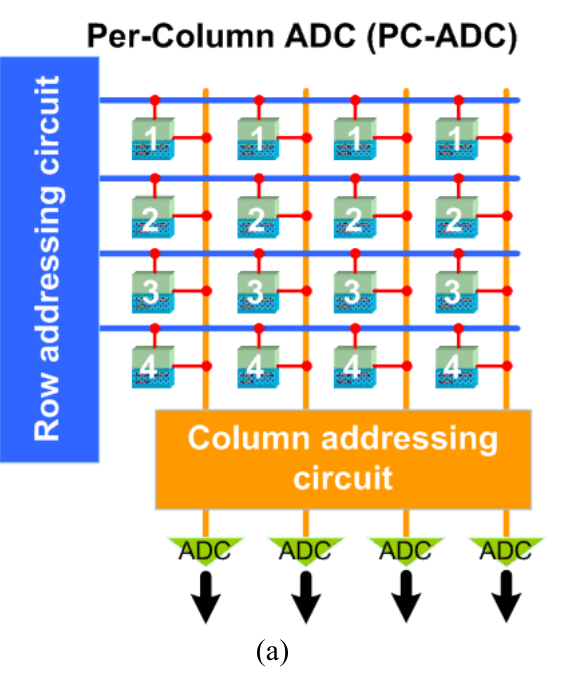
Figure 4. Array access in (a) a per-column ADC (PC-ADC) readout and (b) a PC-ADC 